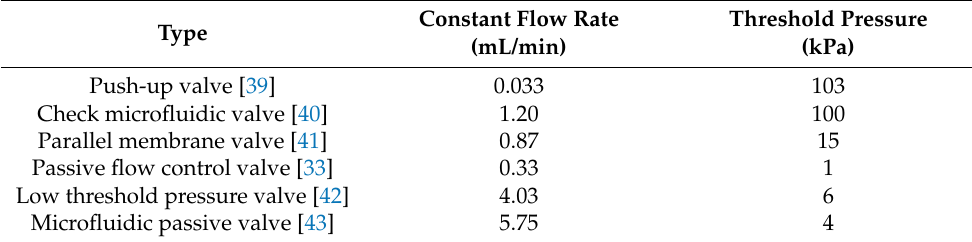
Table 1. The flow regulation capabilities of different